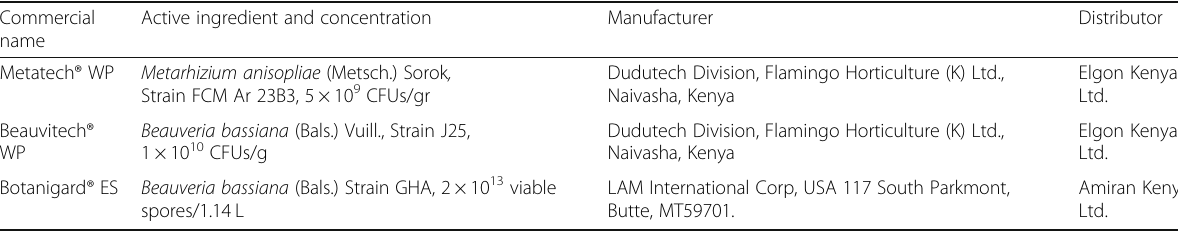
Table 1 Commercial entomopathogenic fungi used in the